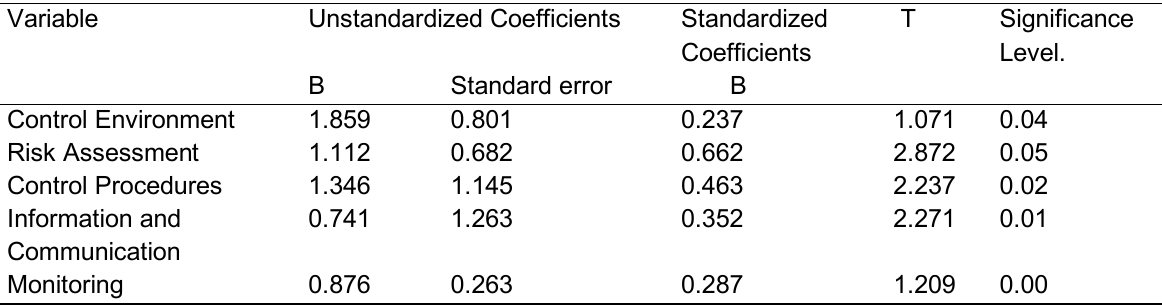
Table 3: Internal Control and